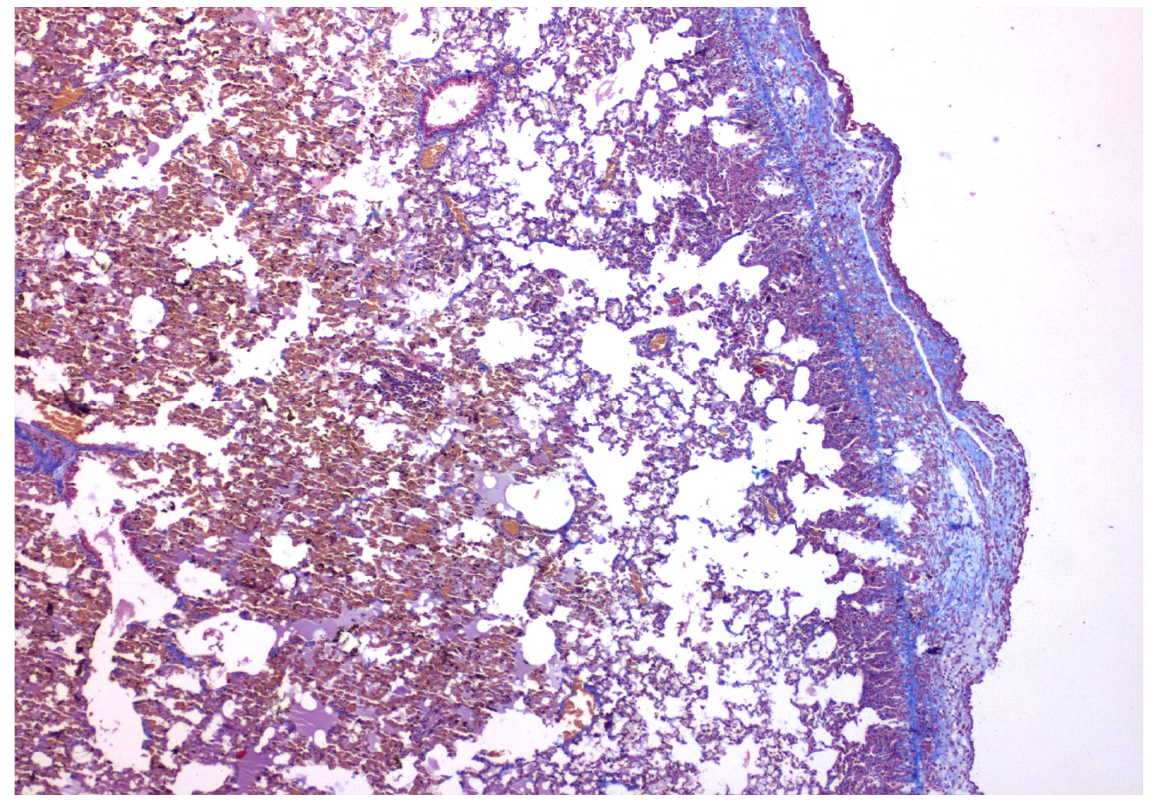
Figure 2. ×40 Masson-Trichrome stain: Following talc installation, fibrosis is present under the mesothelial layer.